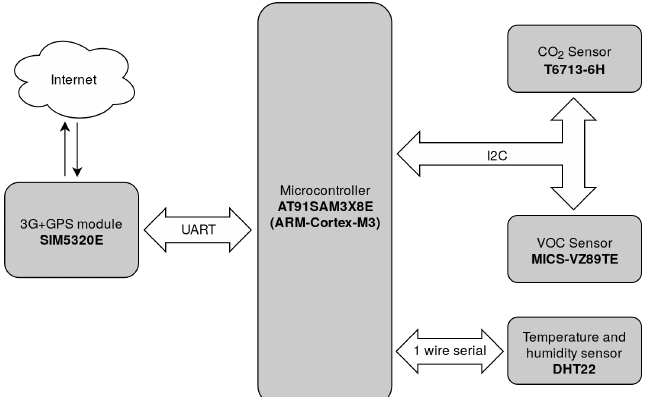
Figure 1. Sensor nodes system diagram.